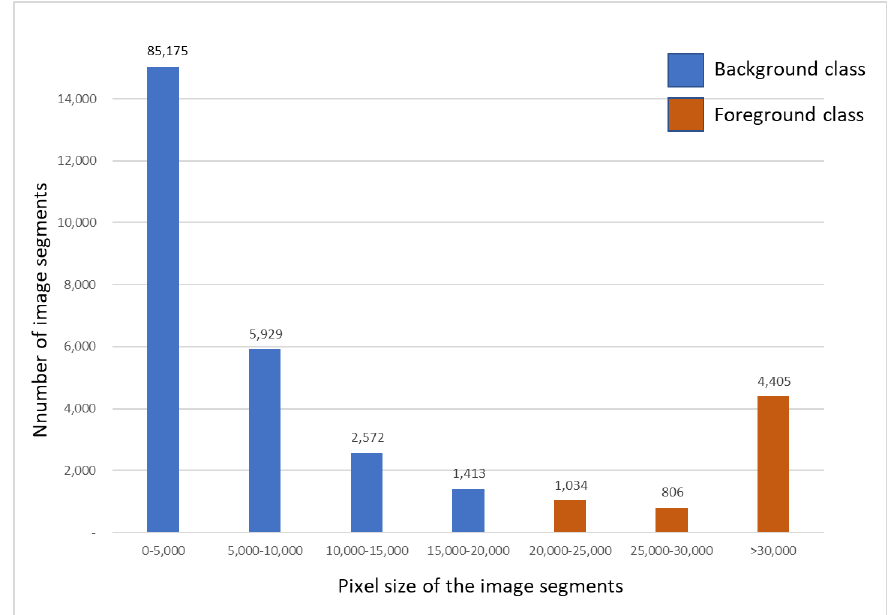
Figure 4. Distribution mapA of the areas of image